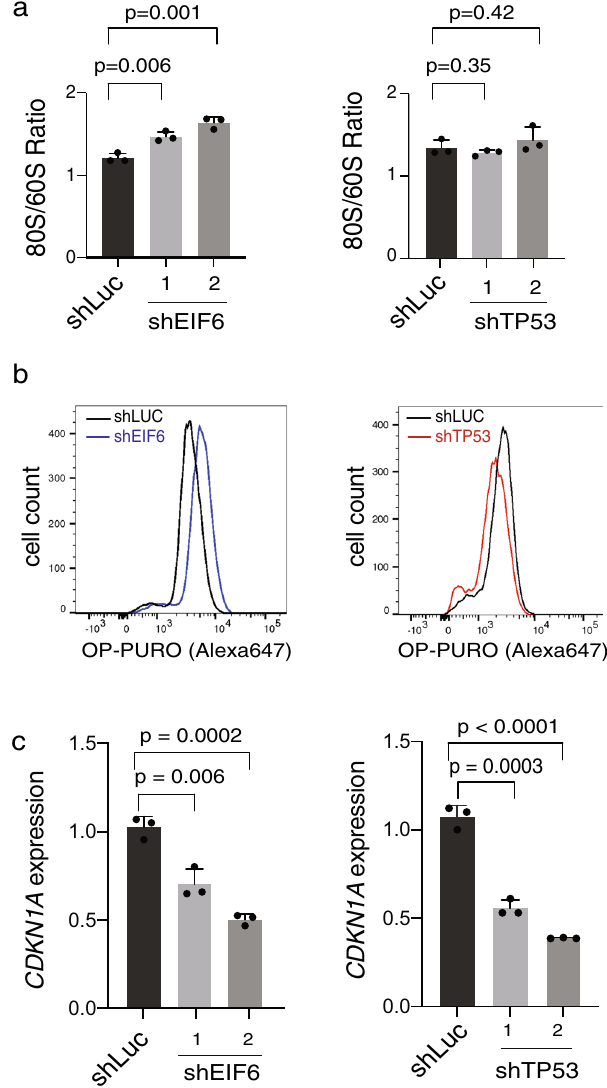
Fig. 3 EIF6 and TP53 mutations attenuate p53 activation via different mechanisms. a Quanti fi cation of 80S:60S ratio from polysome pro fi les in SDS patient-derived primary fi broblasts transduced with shRNAs targeting luciferase, EIF6 (left panel) or TP53 (right panel). b OP-Puro incorporation in primary SDS patient-derived fi broblasts transduced with shRNAs targeting luciferase, EIF6 (left panel) or TP53 (right panel). c Relative CDKN1A expression in SDS patient-derived fi broblasts transduced with either shLUC control or shEIF6 (left panel) and shTP53 (right panel). Error bars represent mean ± standard deviation of three technical replicates representative of two to three independent experiments. p value calculated using unpaired two-tailed t